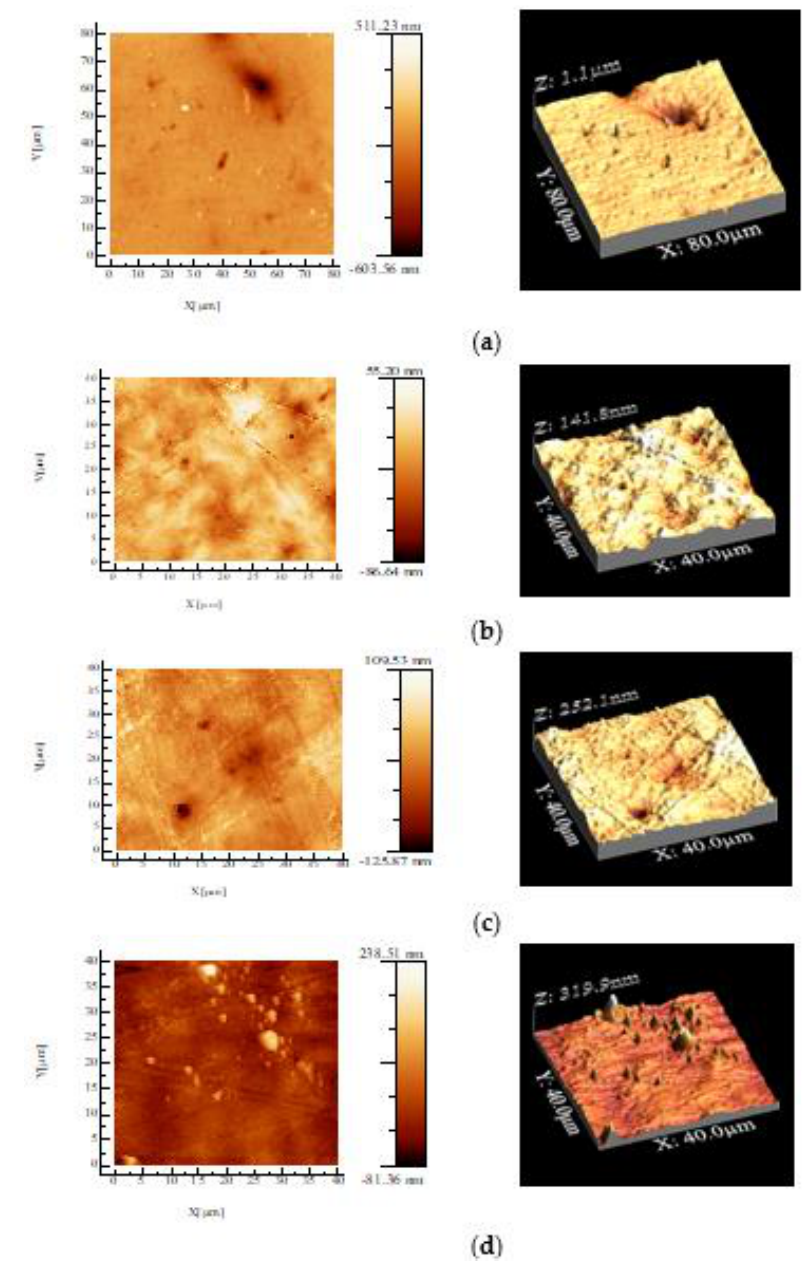
Figure 1. Atomic force microscopy images of PHBV/BC biocomposite films and PHBV film with scanning size of 40 µm × 40 µm and 80 µm × 80 µm, respectively. PHBV neat ( a ); PHBV/Vitamin E ( b ); PHBV/BC1% ( c ); PHBV/BC2% ( d ).